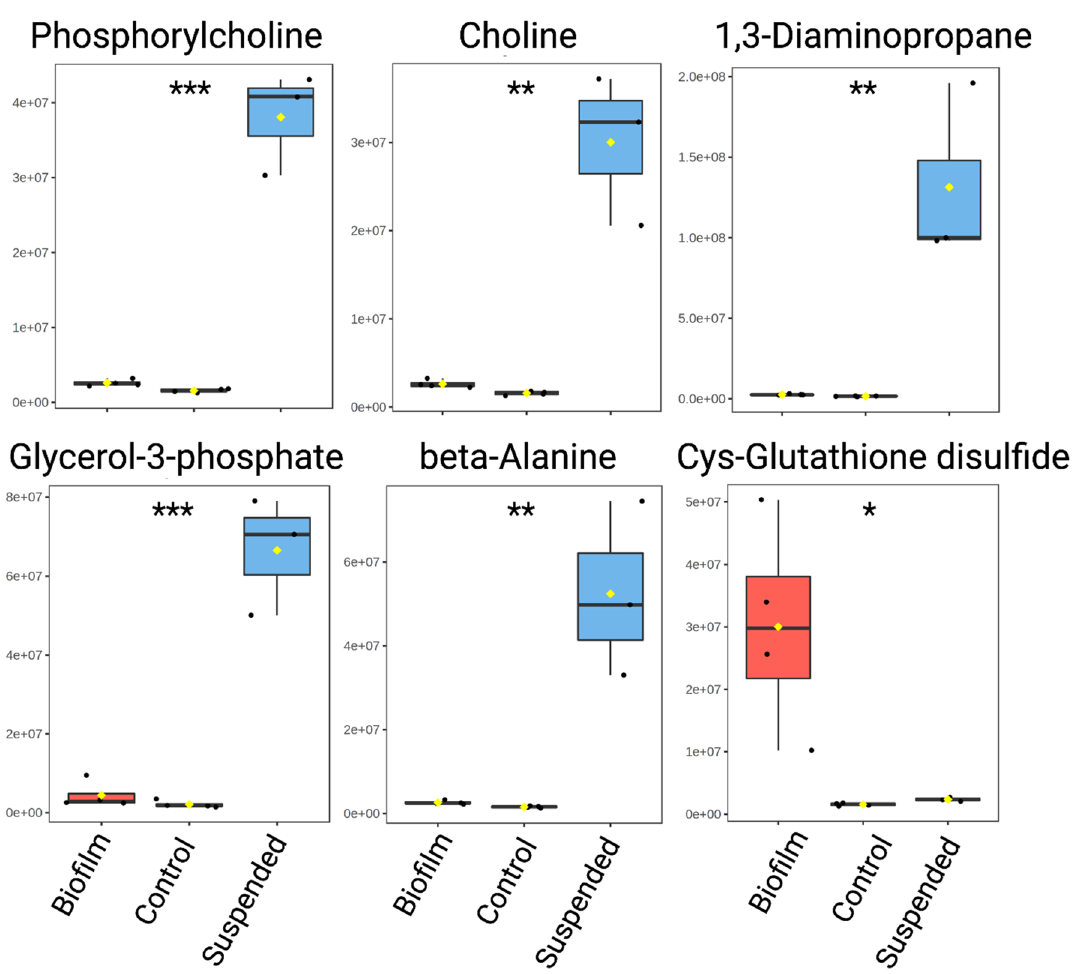
Figure 6. Uniquely detected metabolites in suspended or lawn biofilm cultures. The box plots represent a metabolite quantity analysis between the uninoculated BSF control (green) (n = 4), suspended (blue) (n = 3), and lawn biofilm (red) (n = 4) cultures. The black circles represent independent sample values, boxes represent upper and lower quartiles, black bars represent median, yellow diamonds represent the mean value, and whiskers represent minimum and maximum values, and asterisks denote significance between suspended culture and biofilm sample cohorts (* p < 0.05, ** p < 0.01, *** p < 0.001 by unpaired, two-tailed t -test) ( Cys